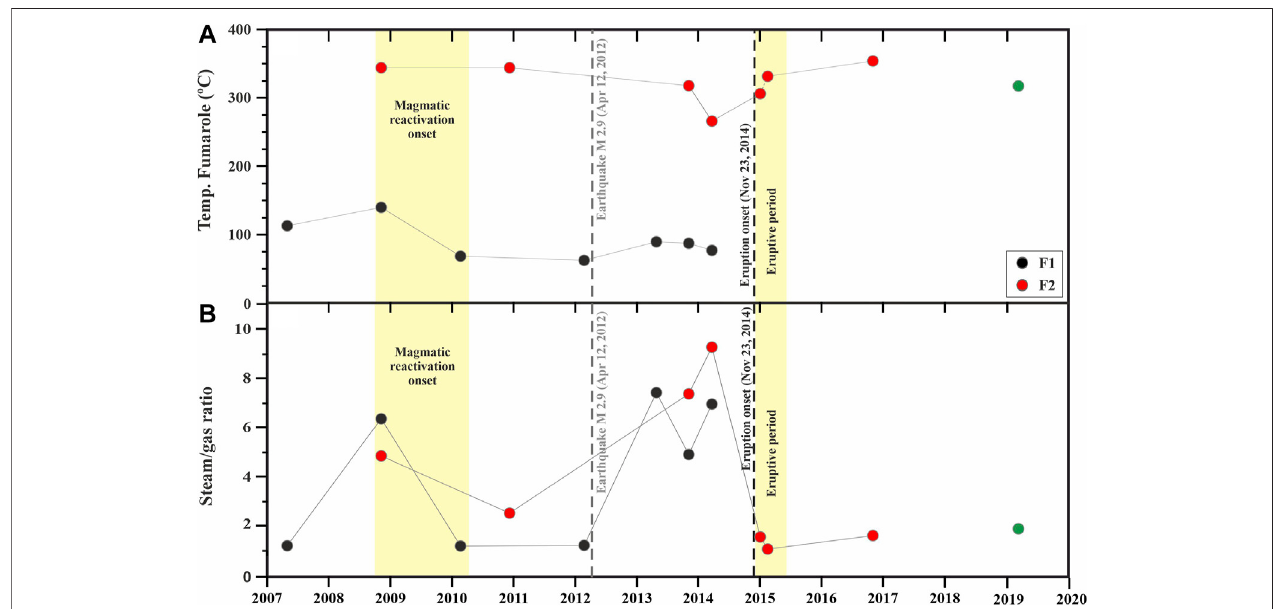
FIGURE 5 | Temporal evolution of (A) fumarole temperatures ( ° C) and (B) steam/gas ratios measured in the Pico do Fogo fumaroles discharges. Green dots represent data from Aiuppa et al. (2020).